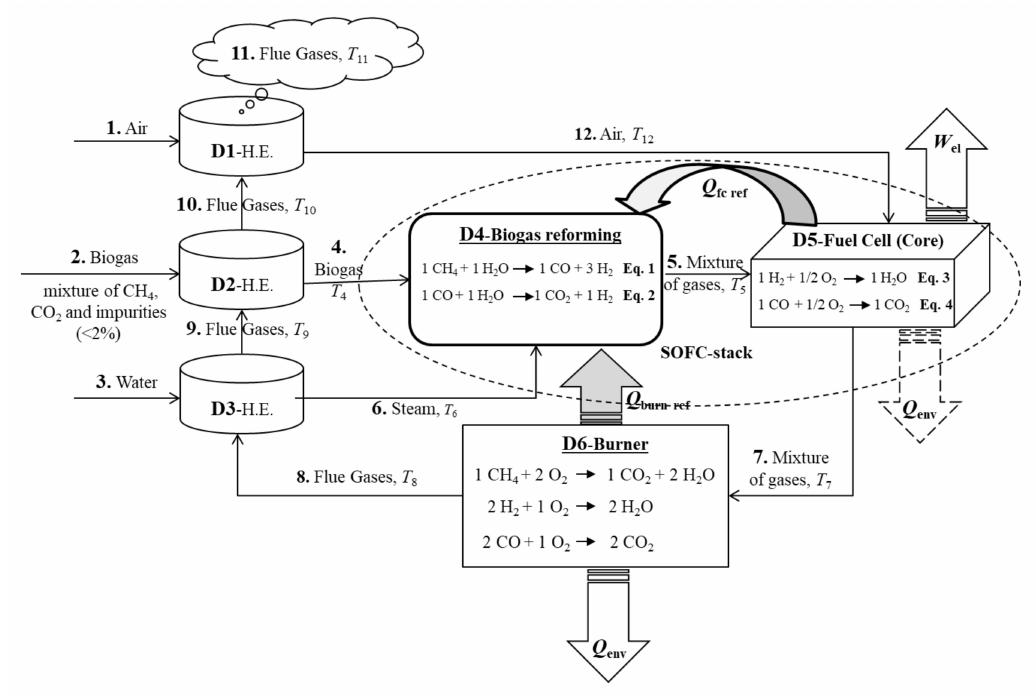
Figure 1. Flow chart of the power